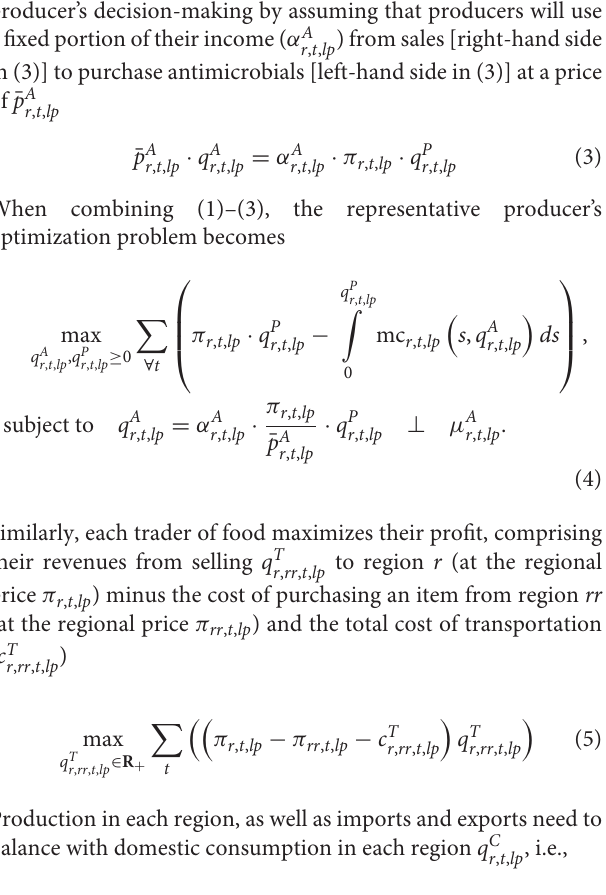
TABLE 2 | Description of model sets, parameters, variables. Element